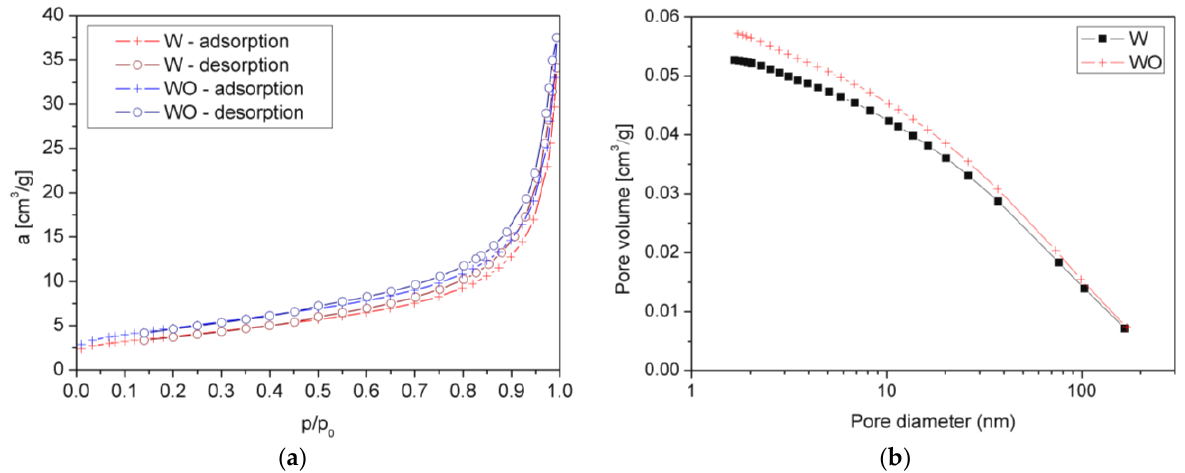
Figure 3. Nitrogen adsorption-desorption isotherms of thermally expanded vermiculite (W) and vermiculite additionally treated with H 2 O 2 (WO).